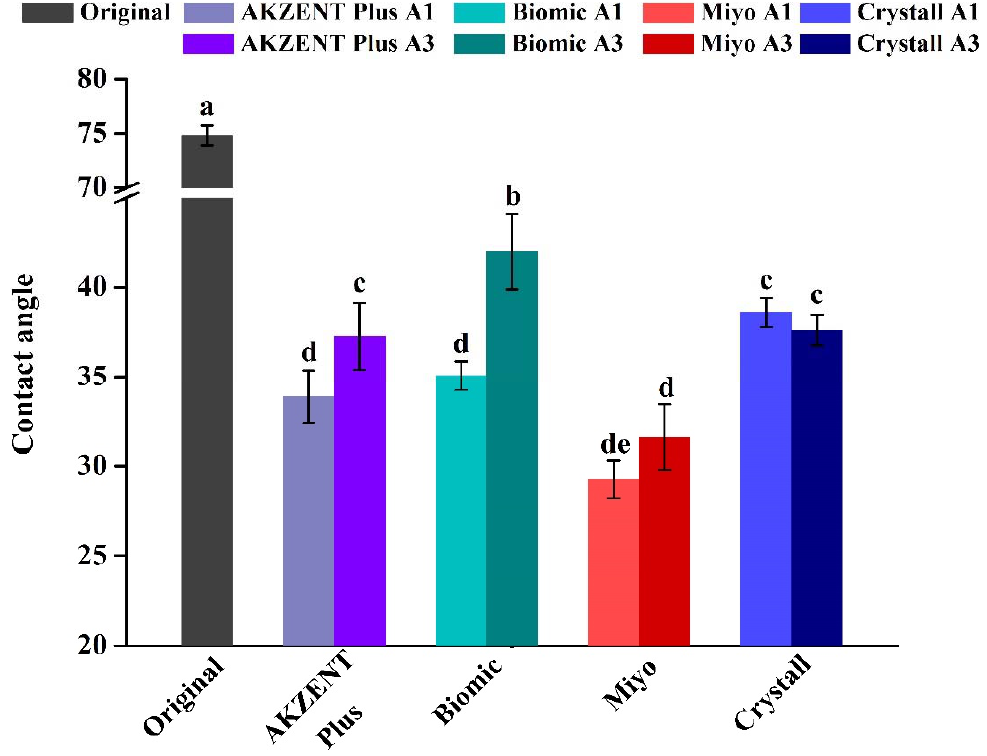
Figure 5. Comparison of the contact angle values of the zirconia samples after staining. Means with different letters were significantly different ( p < 0.05, mean ± SD, n = 5).